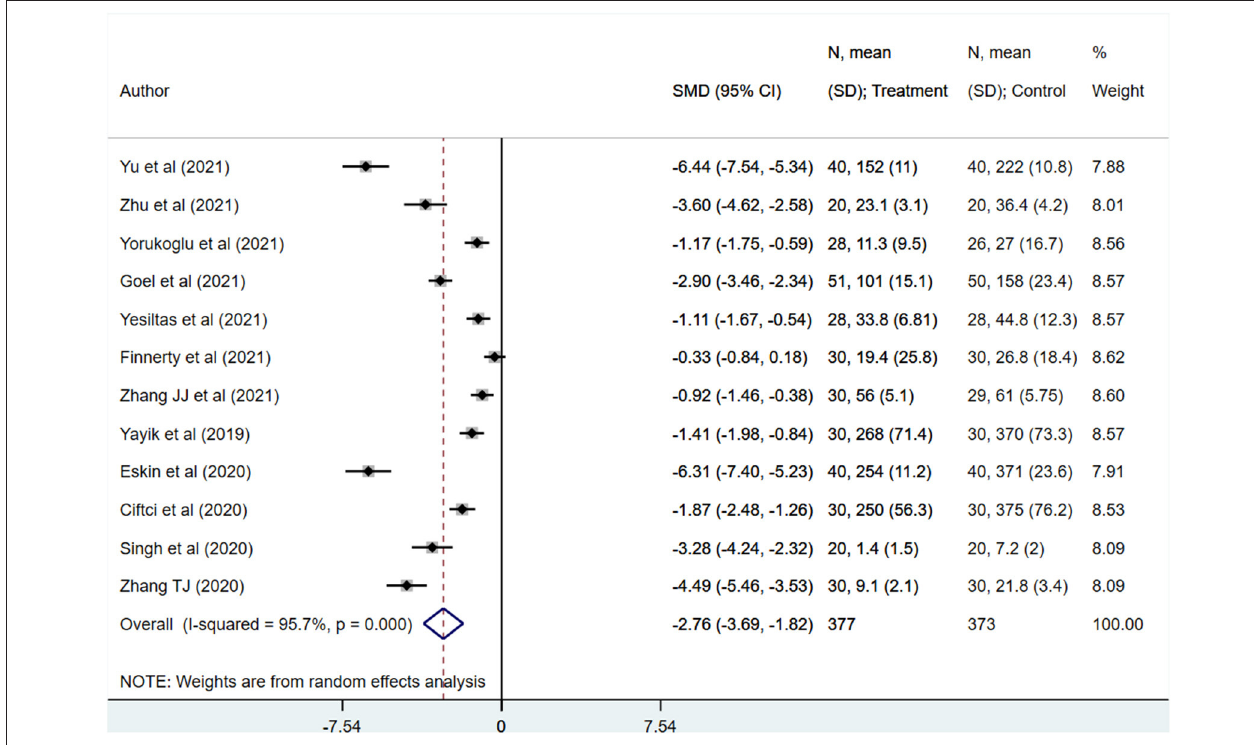
FIGURE 2 | Comparison of postoperative opioid consumption among subjects with erector spinae plane block, compared to placebo or no block.